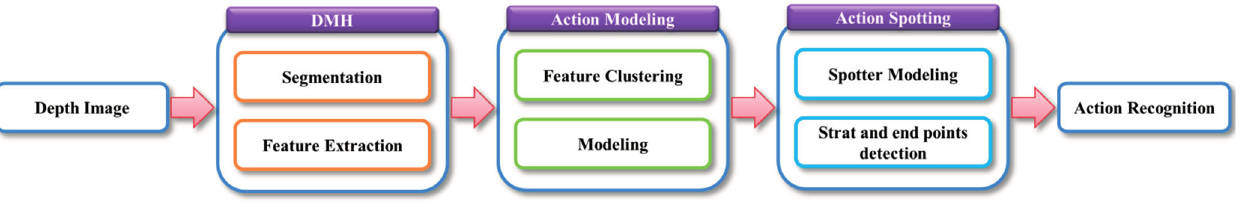
Figure 1. The proposed system process for continuous human action